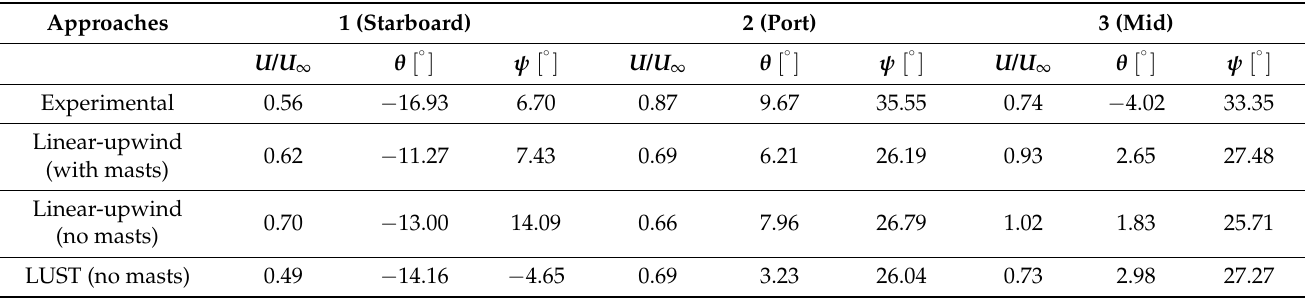
Table 2. Mean velocity magnitude ( U / U ∞ ), pitch θ [ ◦ ], and yaw ψ [ ◦ ] in CPF airwake with red 20 ◦